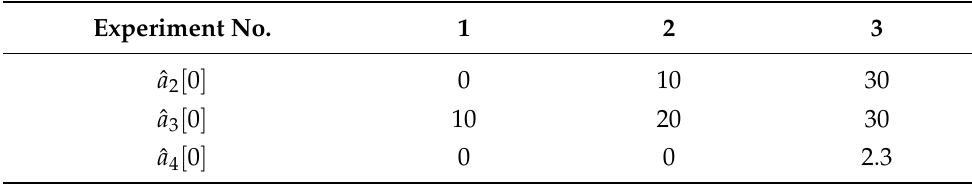
Table 1. Spinner System Identification Initial Conditions.